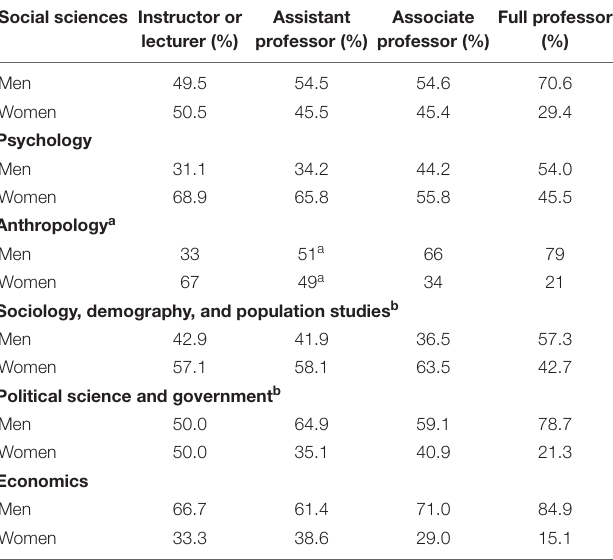
TABLE 2 | Gender representation among social science faculty positions by